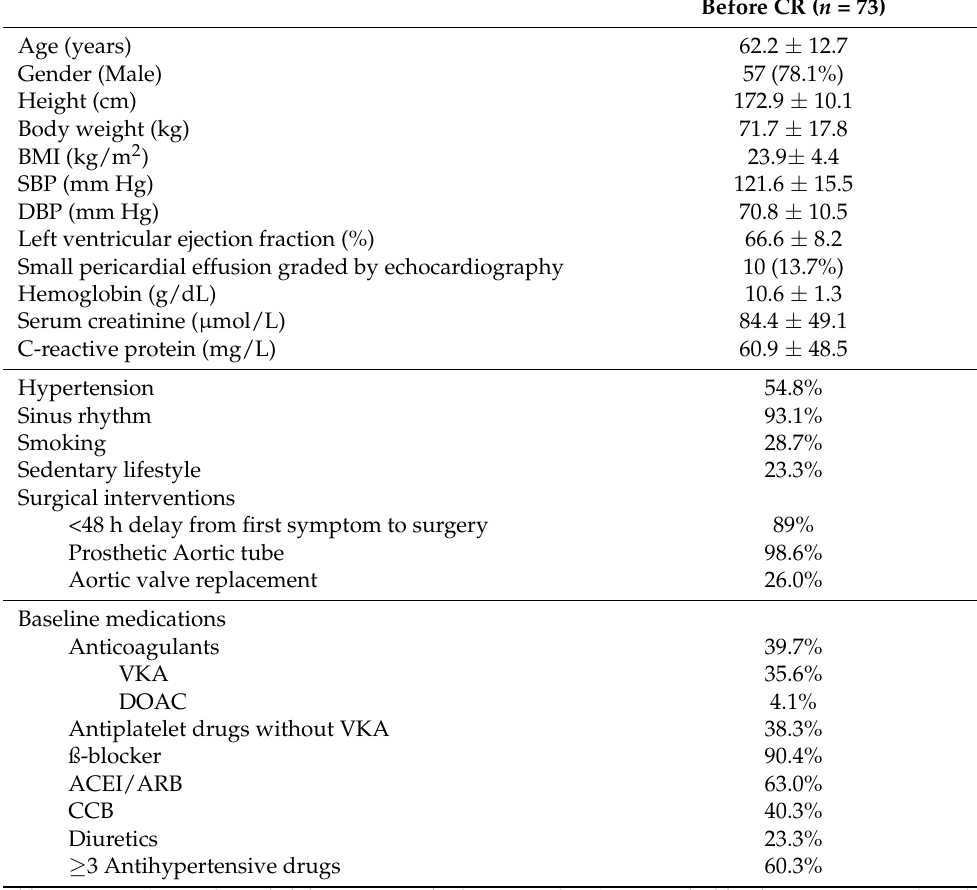
Table 1. Baseline